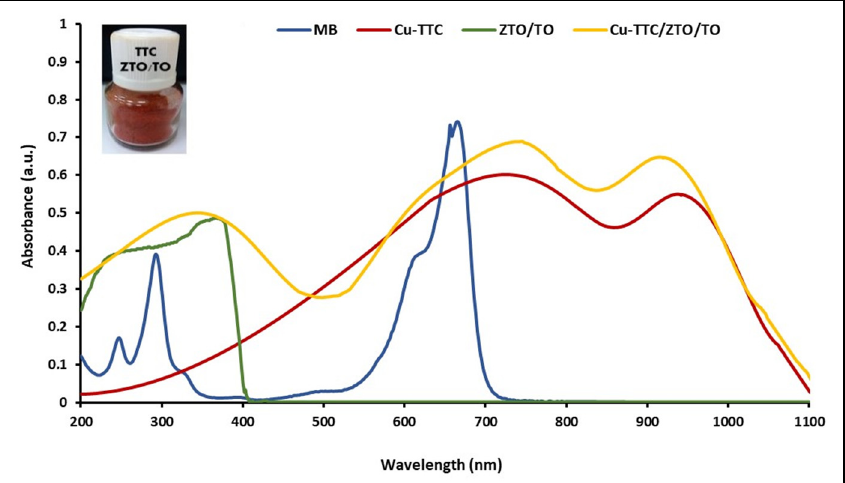
Figure 3. UV-Vis absorption spectra of MB, ZTO/TO, Cu-TTC and Cu-TTC/ZTO/TO.